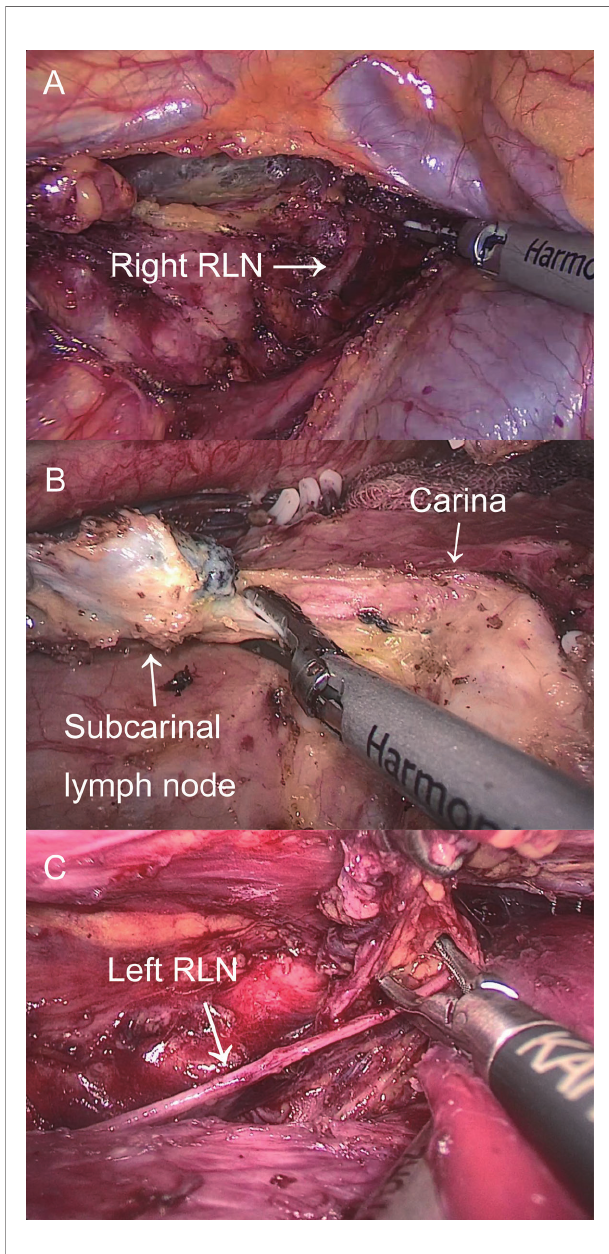
FIGURE 2 | The thoracic operation. (A) Exposure of right RLN and LN dissection around the right RLN. (B) LN dissection on the carina. (C) Exposure of left RLN and LN dissection around the left RLN.